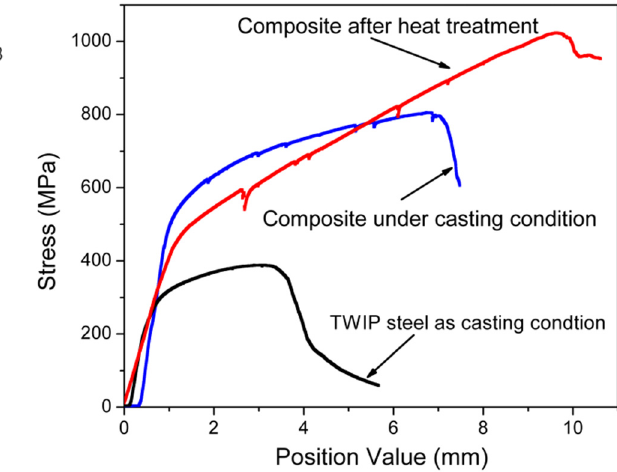
Figure 7: Bending strength of composite structure before and after heat